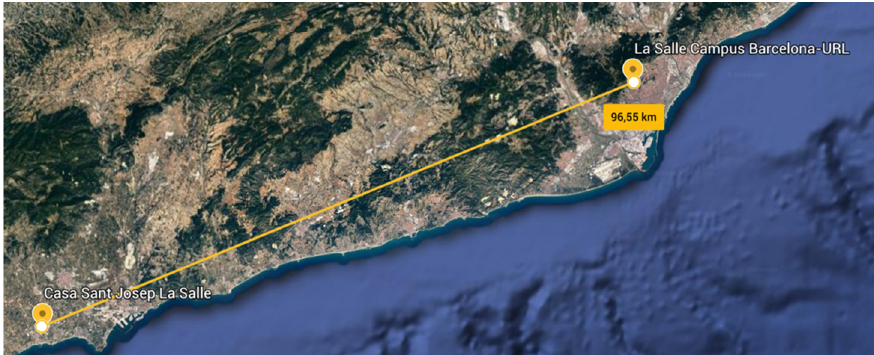
Figure 7. Location of the transmitter and receiver for the channel sounding.